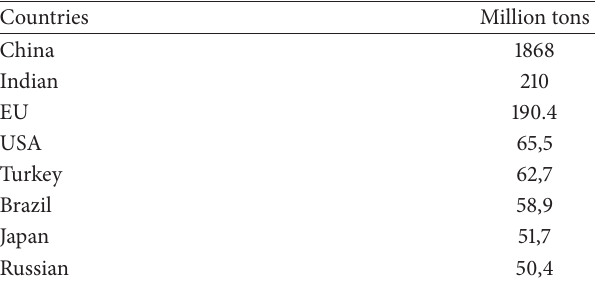
Table 1: Cement production values,